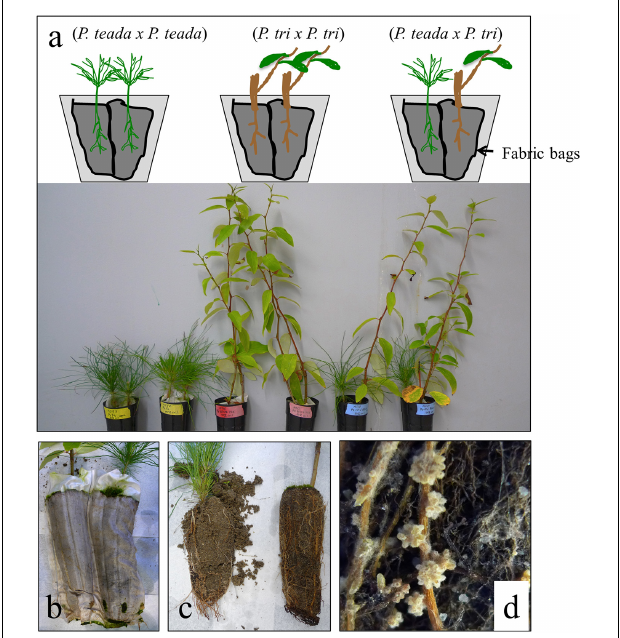
FIGURE 1 | Heterospecific plant bioassay experimental setup. (a) Young plants of Pinus taeda and Populus trichocarpa BESC4 growing in different combination: P. taeda × P. taeda , P. trichocarpa × P. trichocarpa , and P. taeda × P. trichocarpa . (b,c) The roots of two plants grown in the same pot were separated using synthetic fabric “socks” to prevent direct contact between roots of each plant; (d) Ectomycorrhizal roots observed on P. taeda but not on P. trichocarpa ( Supplementary Table 1 ). P. tri = P. trichocarpa